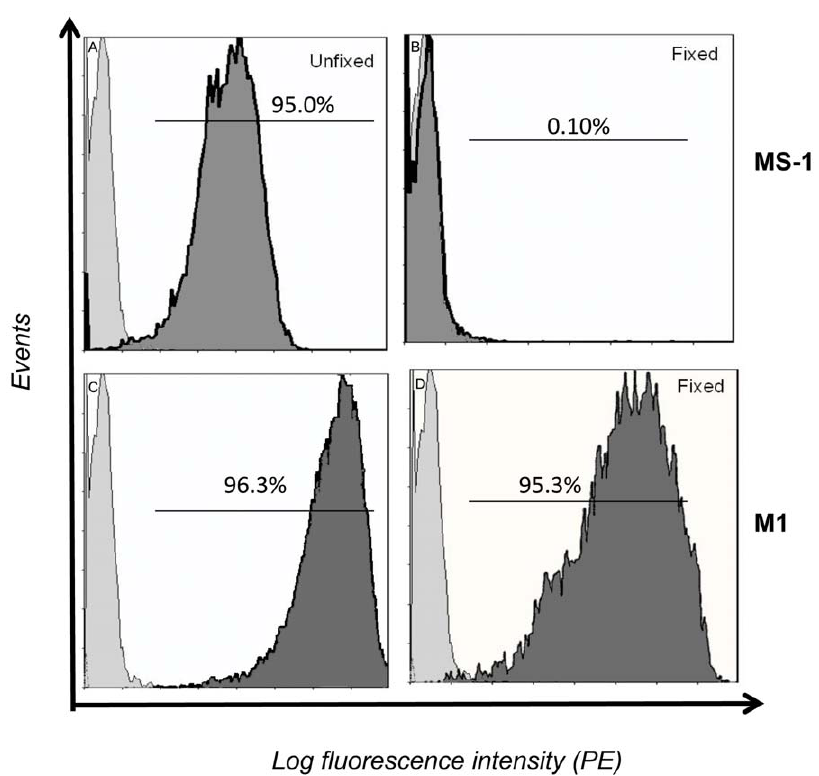
Figure 1. Conformational identity of TSHR antibodies. To show conformational dependence of stimulating TSHR antibodies, CHOTSHR expressing the TSHR were treated with 4% paraformaledhyde for 30 minutes at room temperature and after washing twice with PBS the cells were incubated with 1 ug of antibody for 1 6 10 6 cells/tube of TSHR-mAbs MS-1 or M1 in FACS staining buffer containing 2% FBS (Panels A and B). In parallel, non-paraformaldehyde treated (unfixed) cells were also incubated with the same concentration of MS-1 and M1 antibodies in FACS staining buffer containing 2% FBS (Panels C and D). Treatment of cells expressing the human TSHR with paraformaldehyde destroyed the ability of conformational antibody MS-1 to be recognized whereas the antibody that recognized a linear epitope (M1) was not altered by the